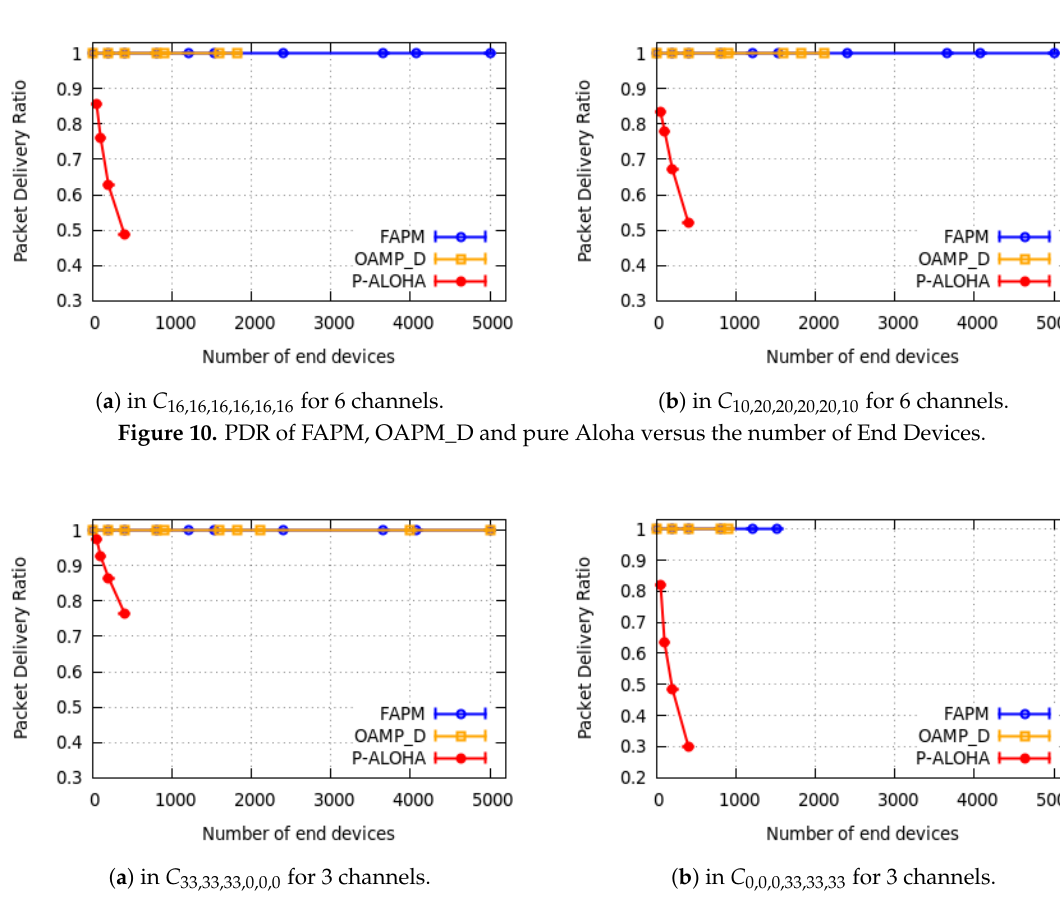
Figure 11. PDR of FAPM, OAPM_D and pure Aloha versus the number of End